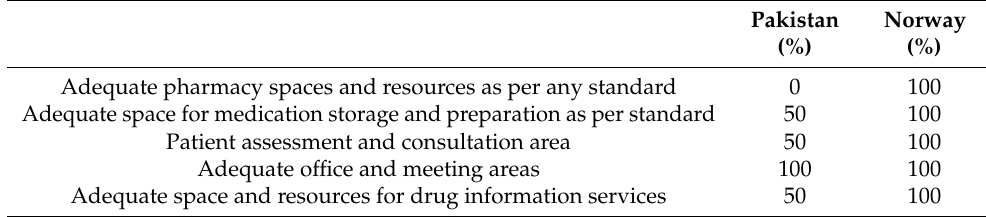
Table 3. Pharmacists’ assessments on pharmacy space and other resources.